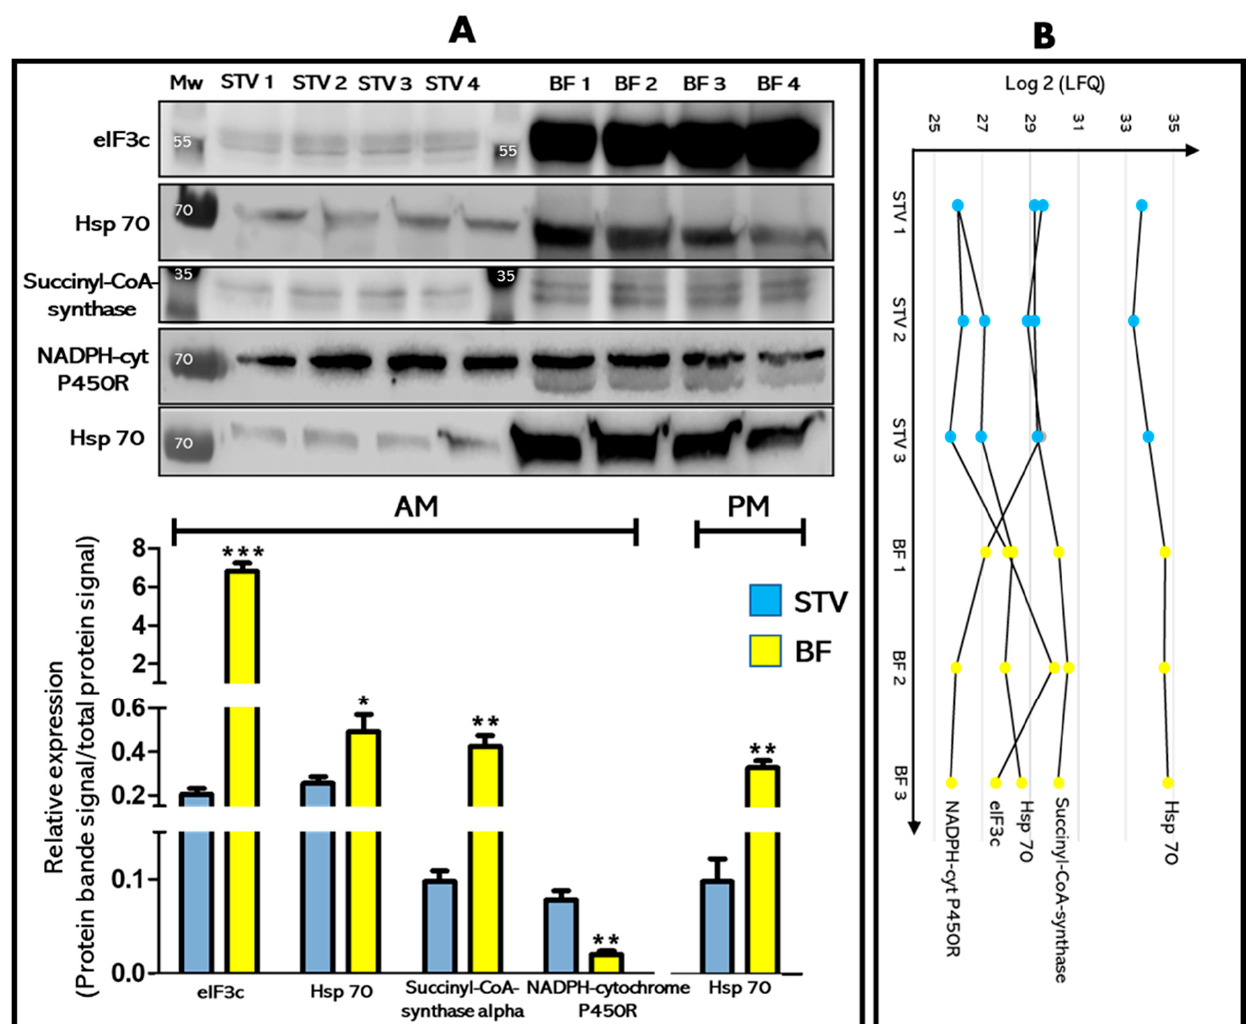
Figure 4. Western blot validation of protein candidates identified as being significantly differentially expressed in the midgut between starved (STV) and blood fed (BF) insects. ( A ) upper panel: Western blot analysis of eIF3c, hsp70, succinyl- CoA-synthase, and NADPH-cytochrome P450 reductase, identified in the AM and hsp70 identified in the PM comparing STV and BF insects. Molecular weight marker is indicated in kDa. ( A ) lower panel: The relative expression of the protein candidates was calculated by normalizing the band intensity of the target protein to the intensity of the total proteins signal. Histogram represents the semi-quantitative Western blot quantification. The results are expressed as the mean ± SEM ( n = 4), and statistical significance is shown by * p ≤ 0.05, ** p ≤ 0.01 and *** p ≤ 0.001. ( B ) Profile plot representing the Log2 LFQ intensity profiles for the chosen protein candidates comparing the STV and BF conditions ( n = 3).